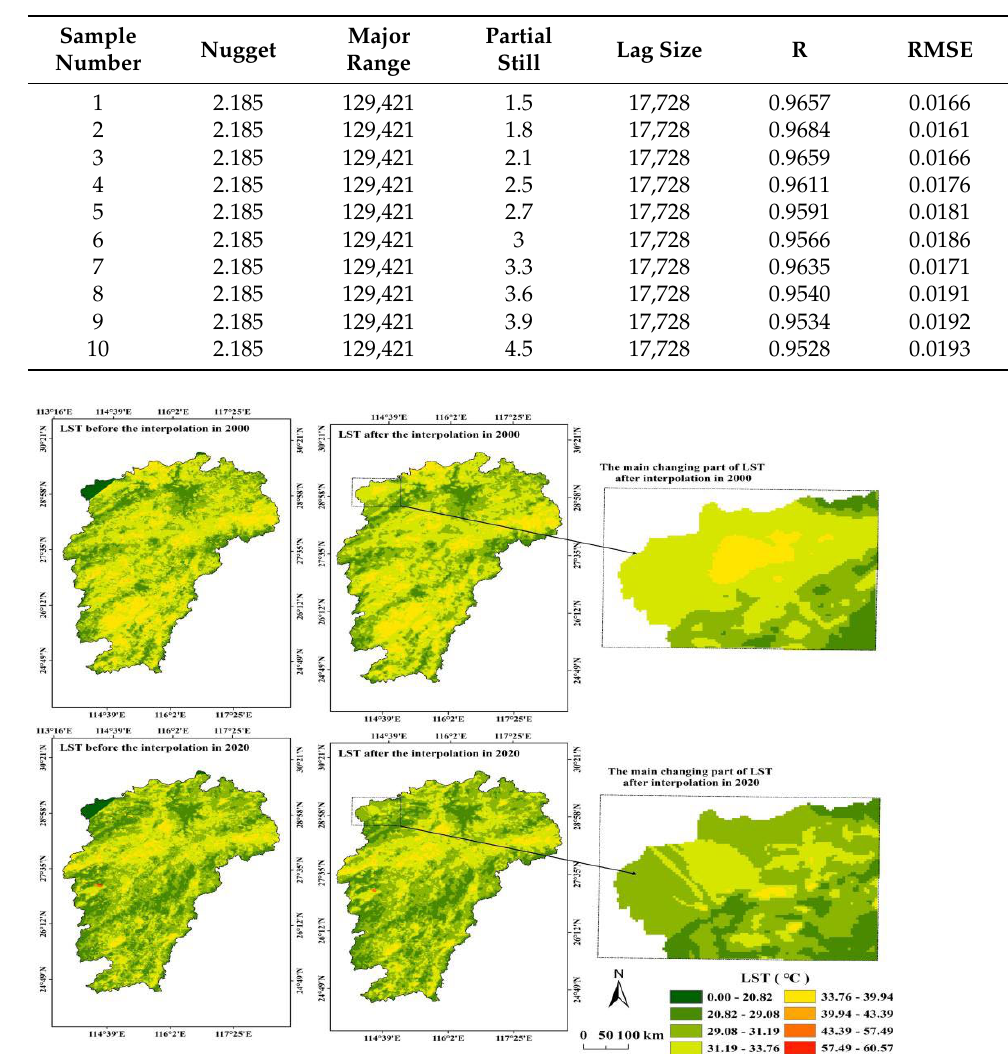
Figure 2. Spatial distribution of LST before and after the interpolation in 2000 and 2020 and the main changes after the interpolation.